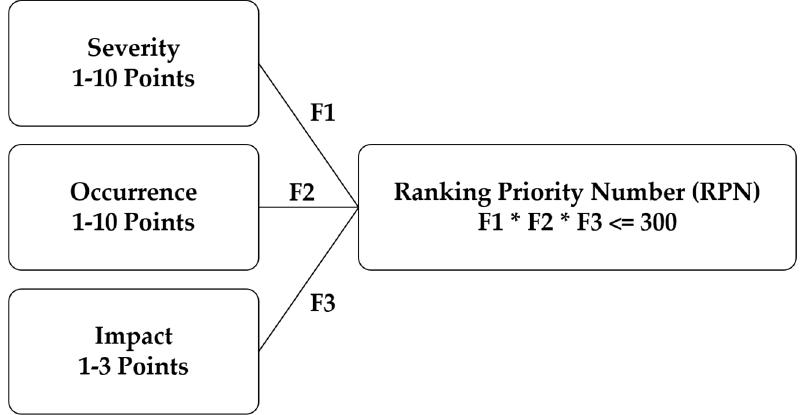
Figure 3. Factors a ff ecting claim ranking and the weight of every Figure 3. Factors affecting claim ranking and the weight of every factor. Figure 3. Factors affecting claim ranking and the weight of every factor.